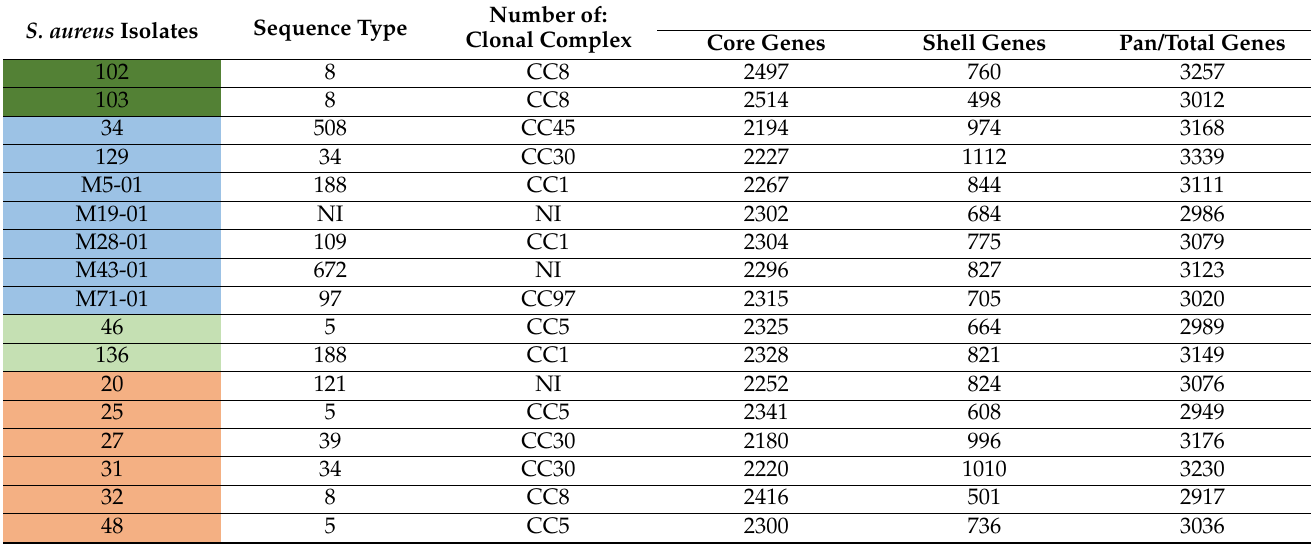
NI = not identified. Isolates highlighted in shades of blue indicate MK strains; dark blue represents MK strains from USA and light blue represents MK strains from Australia. Shades of green indicate conjunctivitis strains; dark green indicates conjunctivitis strains from USA and light green indicates conjunctivitis strains from Australia. The peach color indicates strains from niCIE. strains. Australian strains clustered into sub lineages within group 3, whereas USA iso- lates with same ST8 clustered together within group 3.